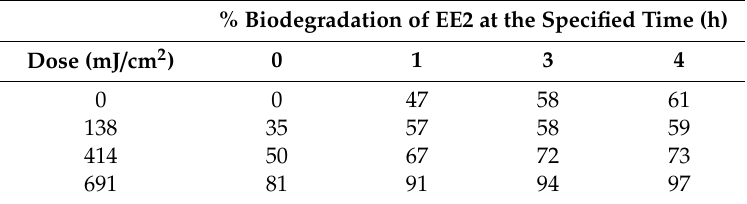
Table 2. Biodegradation of 3 ppm EE2 by SBP capsules after photocatalytic treatment by MgO 2 . % Biodegradation of EE2 at the Specified Time